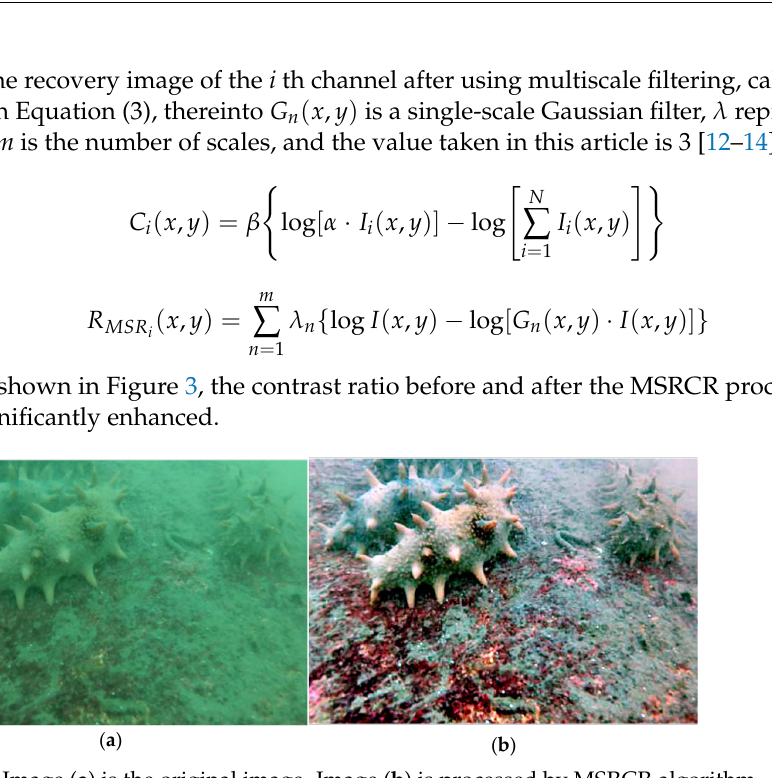
Figure 3. Image ( a ) is the original image. Image ( b ) is processed by MSRCR algorithm.